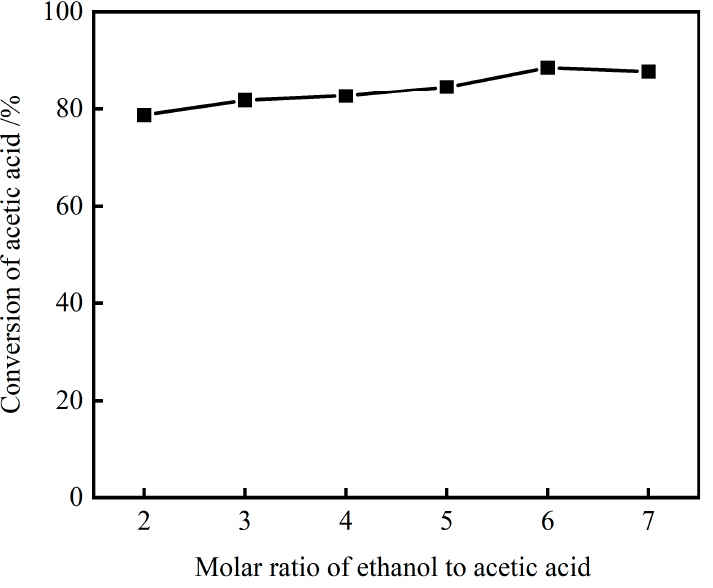
Figure 8. The impact of molar ratio of EtOH to HOAc on the conversion rate of HOAc (reaction conditions: 0.5359 g catalyst loading, 80 °C, 3 h, 640 rpm).